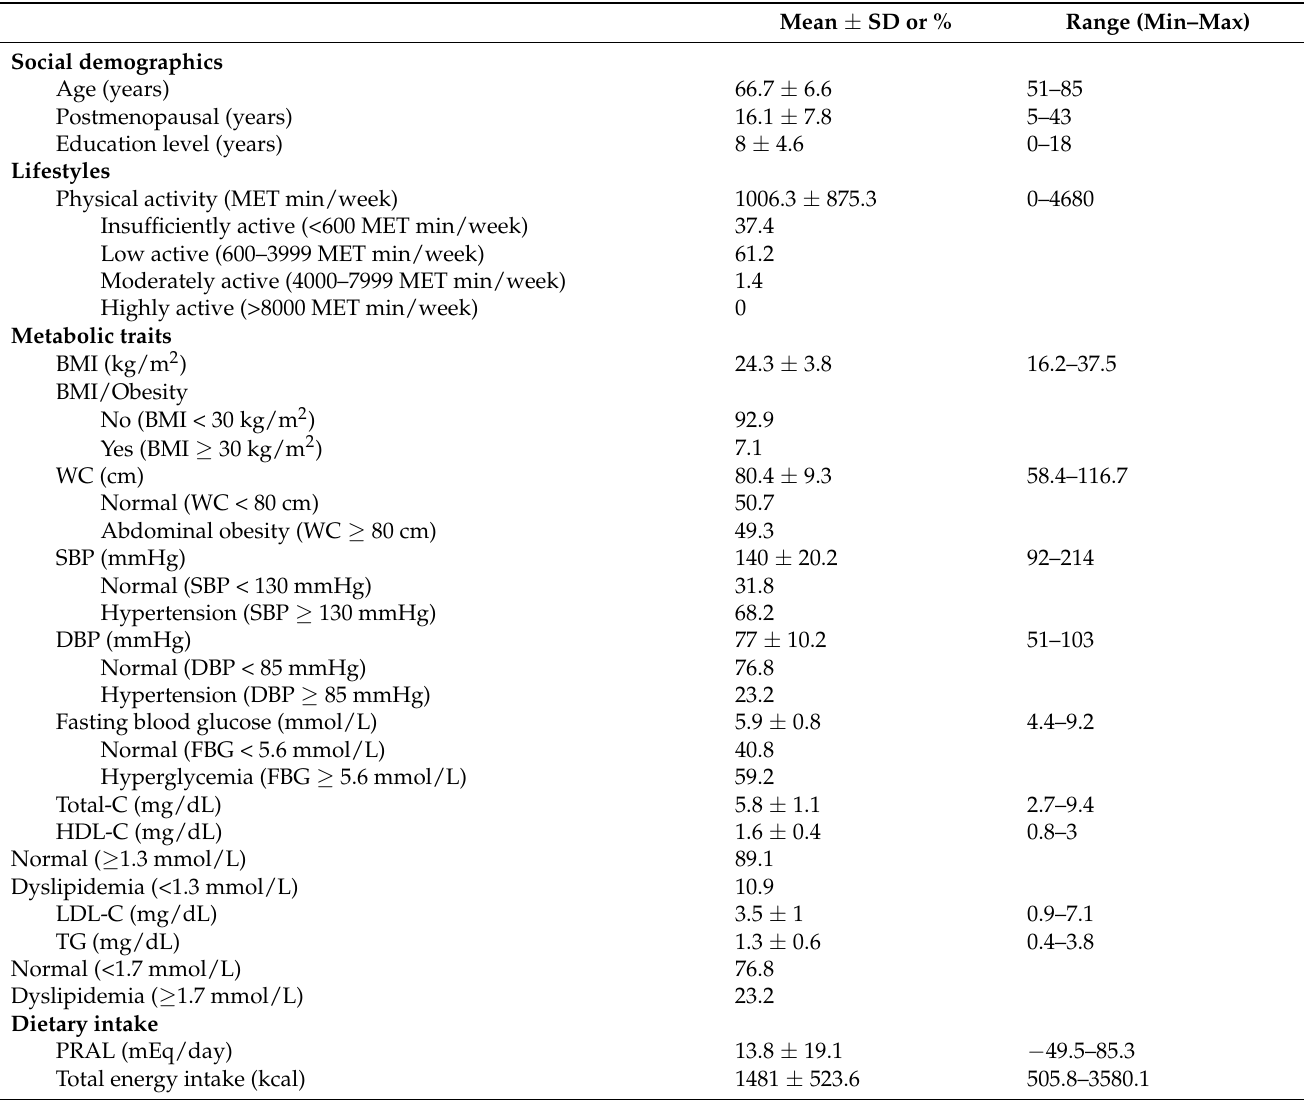
Table 2. Demographics, anthropometrics, lifestyles, metabolic traits, and genetic analyses of postmenopausal women ( n = 211).